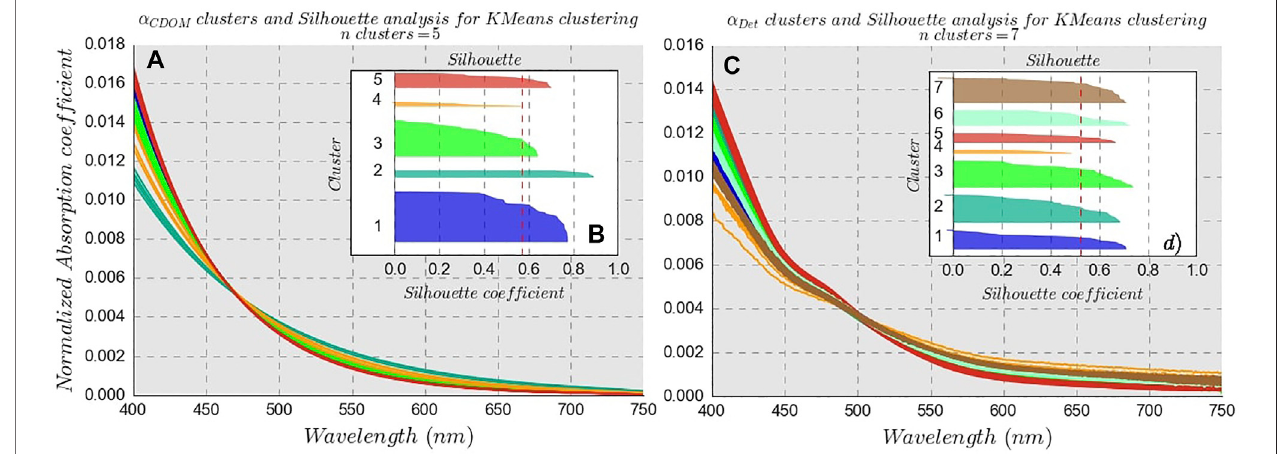
FIGURE 3 | (A) α CDOM ( λ ) spectral shapes of each cluster; (B) silhouette analysis of α CDOM ( λ ) clustering; (C) α det ( λ ) spectral shapes of each cluster; (D) silhouette analysisof α det ( λ )clustering. Reddashed lines at (b)and (d) represent themean valuefor thesilhouette coef fi cient.The spectral shape colorsare thesame asthe onesin the silhouette cluster